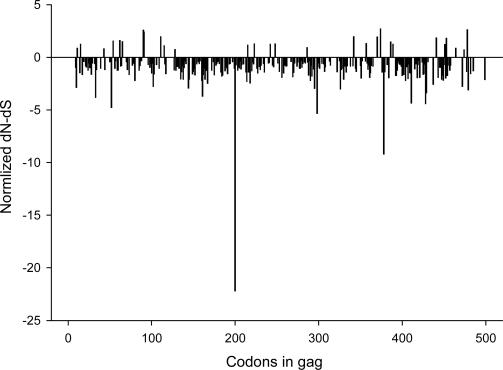
Normalized dN-dS values across gag codons. P-values were derived from a two-tailed extended binomial distribution. A total of 31 positively and 242 negatively selected sites were found.